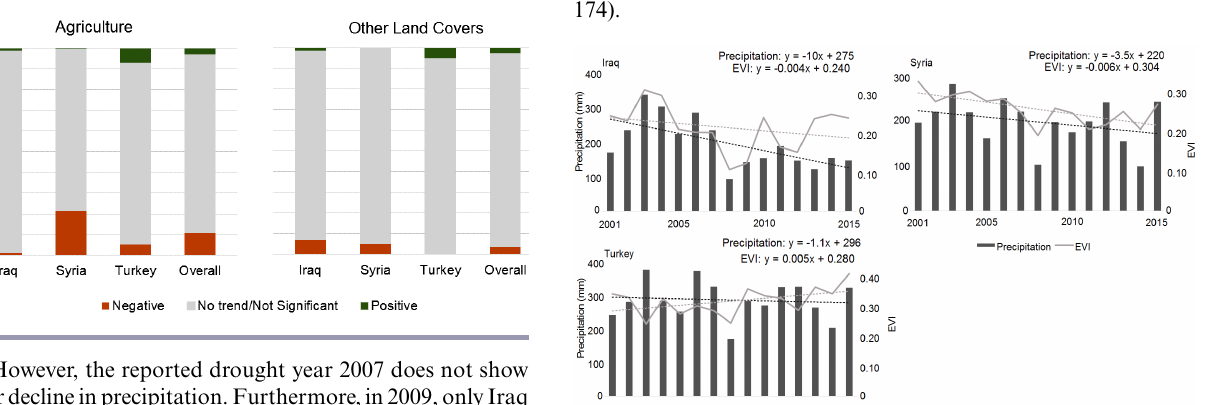
Fig. 3. Share of random points with pixels showing negative, positive, or no trend (total n = 1000) in agricultural areas ( n = 467) and other land covers ( n = 533).